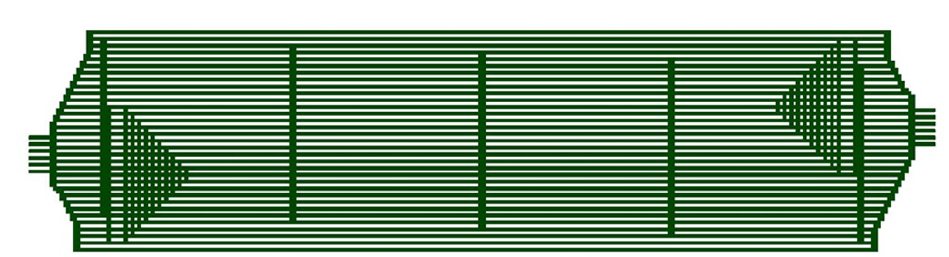
Figure 15. Simplified model of the coolant flow field with added manifold regions.